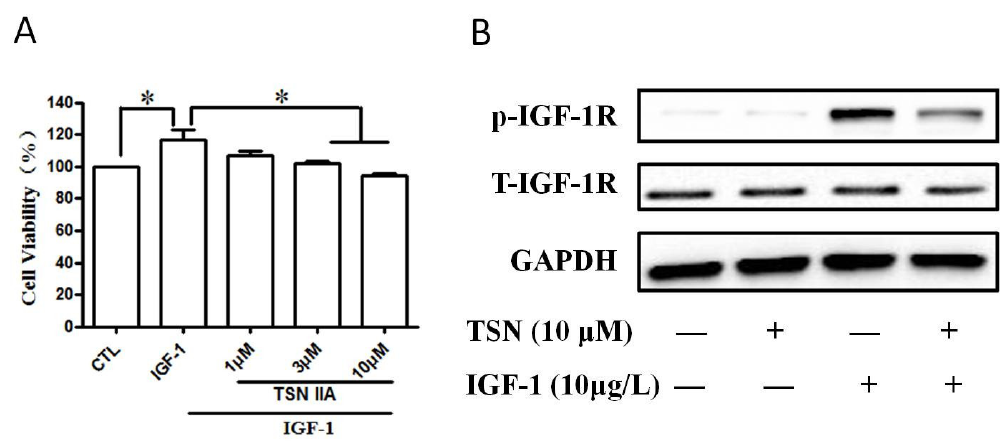
Figure 7. TSN inhibited cell growth induced by IGF-1 and attenuated the phosphorylation of IGF-1R in SH-SY5Y cells. ( A ) Cells were treated with TSN (10 µ M) for 1 h, and were then treated with IGF-1 in a serum-free medium for 24 h. Cell proliferation was determined by MTT assay; ( B ) SH-SY5Y cells were treated with various concentrations of TSN for 1 h, and followed by treatment with 10 µ g/L IGF-1. The levels of p-IGF-1R and IGF-1R was determined by Western blot. The data is expressed as mean ± SEM, n = 3. * p < 0.05, compared to control.